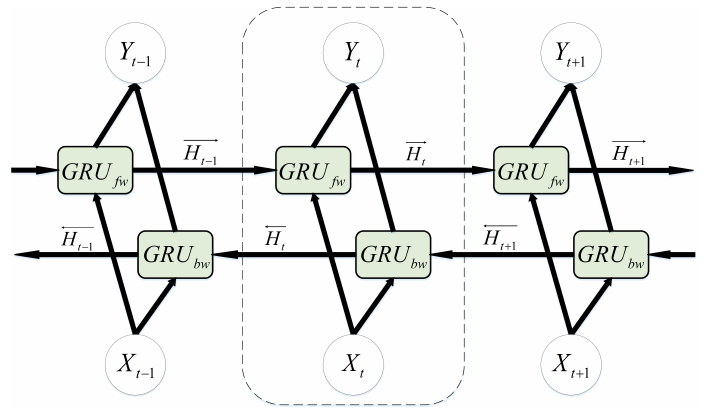
Figure 2. Bidirectional gated recurrent unit [29]. The forward hidden GRU layer ( (cid:126) H t ) and the backward hidden GRU layer ( defined as in Equation